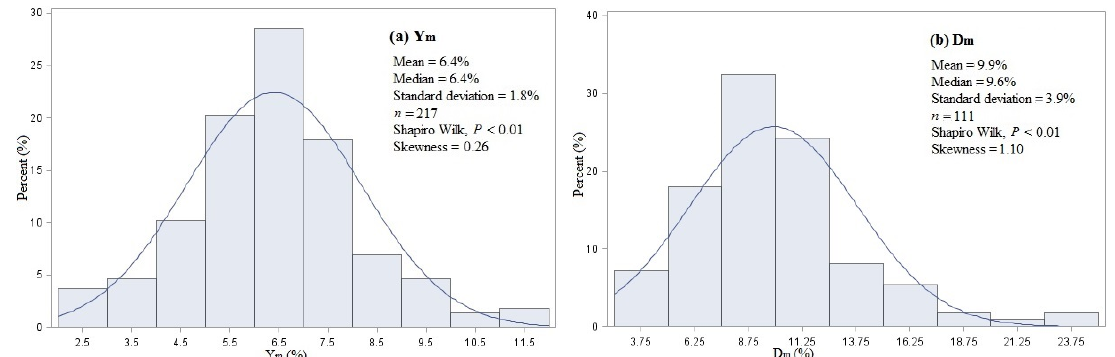
Figure 5. Histograms of CH 4 conversion factors on gross energy intake (GEI) or digestible energy basis: ( a ) Y m : CH 4 loss as a percentage of GEI; and ( b ) D m : CH 4 loss as a percentage of digestible energy intake.